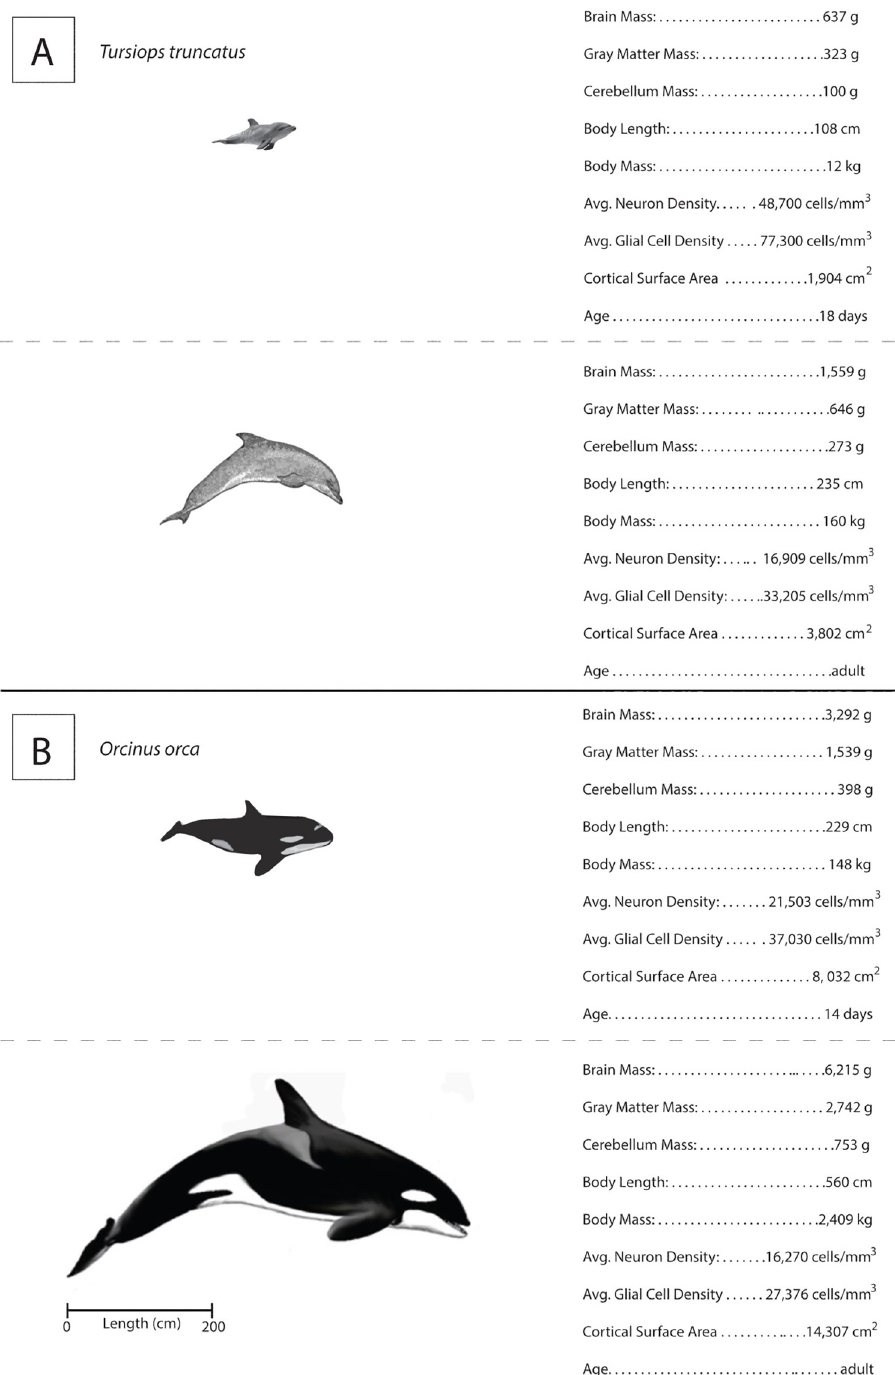
PLOS ONE | https://doi.org/10.1371/journal.pone.0226206 December16,